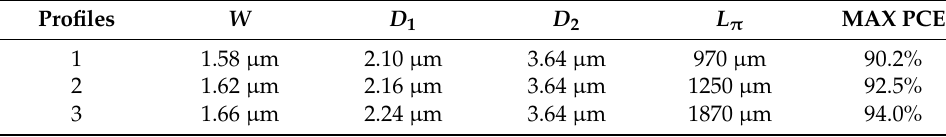
Figure 6. Periodic PCE curves of the three profiles.